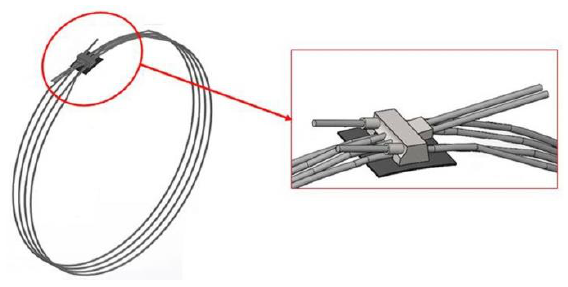
Figure 4. The system of each anchorage.